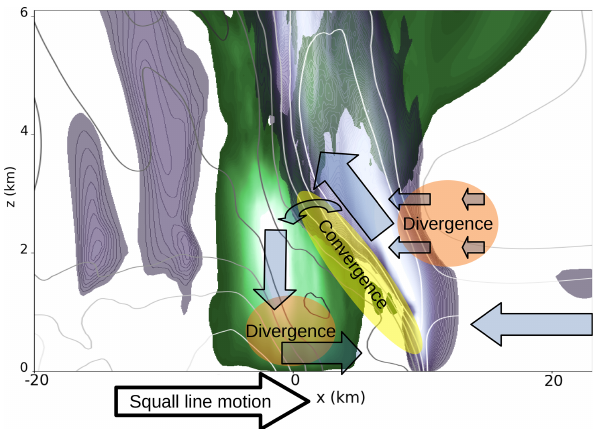
Figure 9. Schematic picture of the cold pool circulation in an x – z cross section: green colouring shows updraught mass fluxes, purple colouring shows downdraught mass fluxes. The white isolines in- dicate easterly flow ( − 9ms − 1 , every 3ms − 1 ), while darkest grey ones indicate westerly flow (+6ms − 1 ). One can identify conver- gence and divergence zones from these contours, which are con- ceptualised with yellow and orange ovals. The cold-pool-relative flow is given by light blue transparent arrows. Note that the classi- cal pattern of a rear inflow jet (Houze, 2004, and references therein) is practically absent here and that the upper (roughly) half of the troposphere is omitted. The squall line propagation is given by the arrow at the